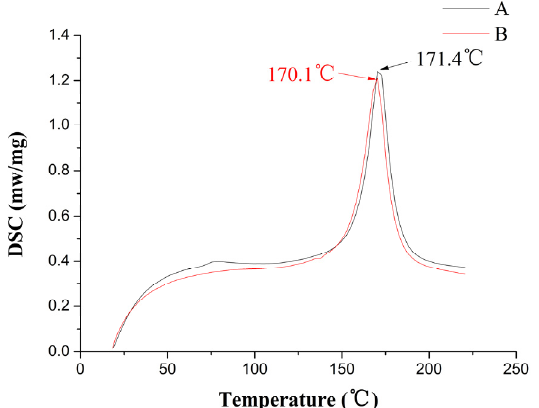
Figure 6. The DSC curves of PP and